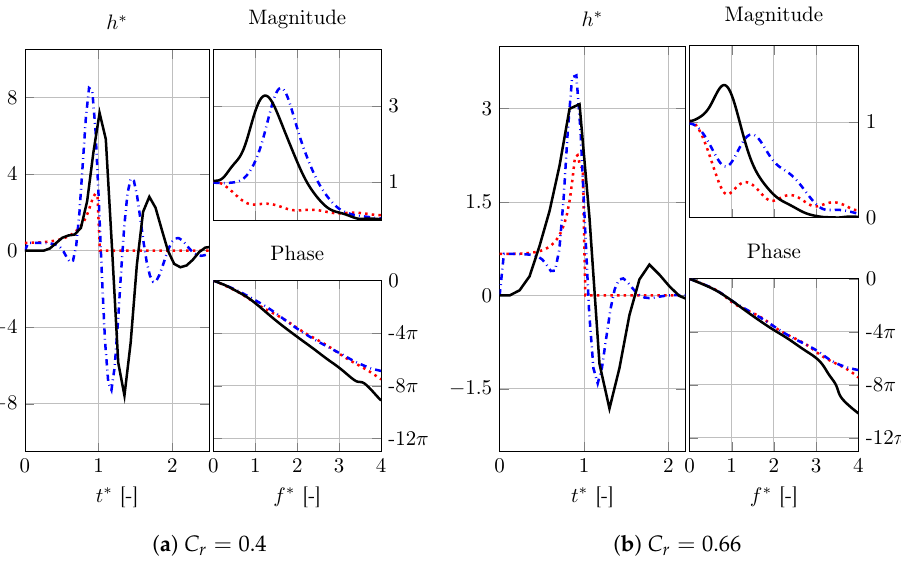
Figure 11. Impulse responses (left plot in sub-figures ( a , b )) and frequency responses (right plots in sub-figures ( a , b )). CFD results ( ) vs. predictions of the unidirectional ( ) and bidirectional ( ) models, that is without and with consideration of flame-generated vorticity ( r 0, ω ,min = 4.25 l M